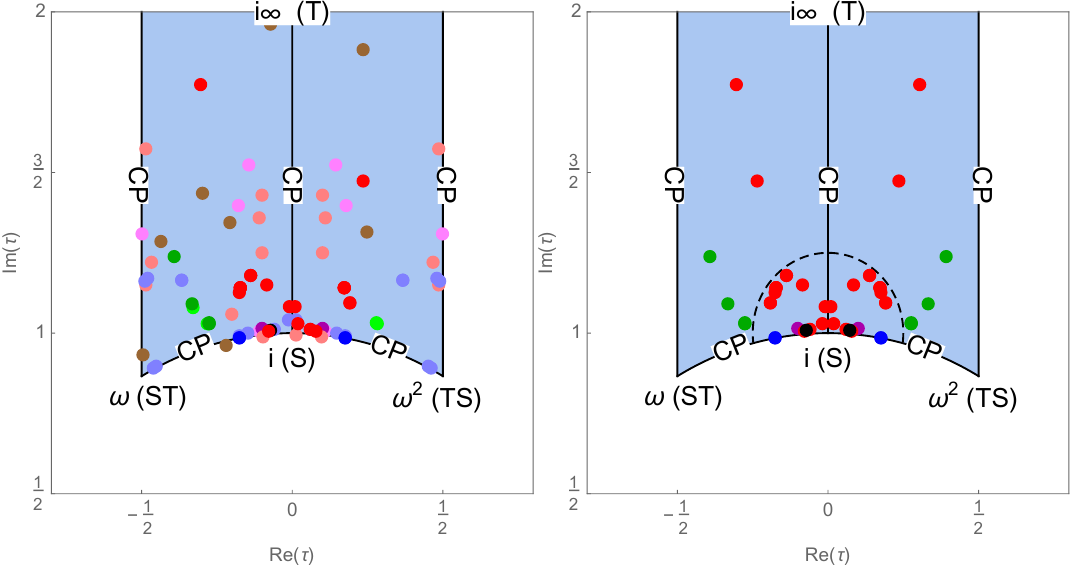
Figure 4 . Fundamental domain F (light blue region) and fixed points (see text). Dots are the best-fit values of τ in models of refs. [66, 68] ( Γ 3 - light red), [69, 70] ( Γ 3 & CP - red), [71] ( Γ 4 - light magenta), [67] ( Γ 4 & CP - magenta), [72] ( Γ 0 - light blue), [72] ( Γ 0 & CP - blue), [73] ( Γ 0 & CP 4 4 5 - black), [74] ( Γ 0 - light green), [74] ( Γ 0 & CP - green), [75] ( Γ 7 - brown). We use the notation 6 6 Γ 0 = SL(2 , Z N ) and Γ N = SL(2 , Z N ) / {± 1 } . In the left panel all models are displayed. The right N panel includes only CP invariant models, for which the full pair of points τ and − ¯ τ is shown. The dashed line represents the contour | τ − i | = 0 . 25 .